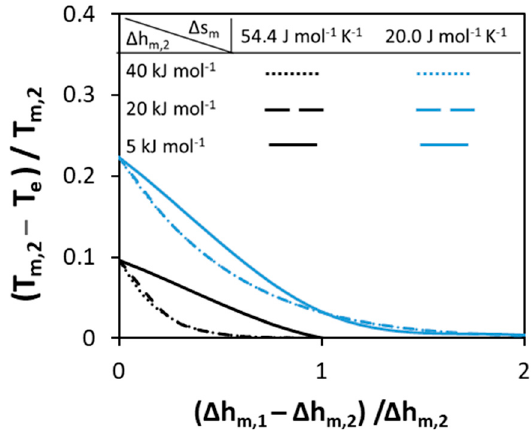
Figure 3. Effect of the melting enthalpies of pure components with constant melting entropy on the normalized depression at eutectic temperature relative to that of Component 2.